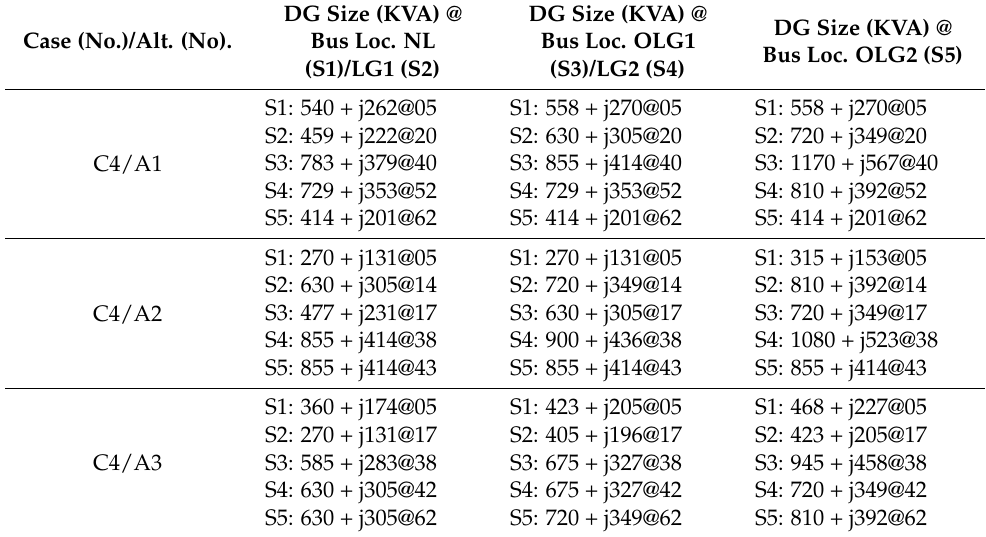
Table 17. Asset set (REG+D-STATCOM) sitting and sizing equal to DG operating at 0.9 LPF for C4/S1–S5 across alternatives in the 65-bus